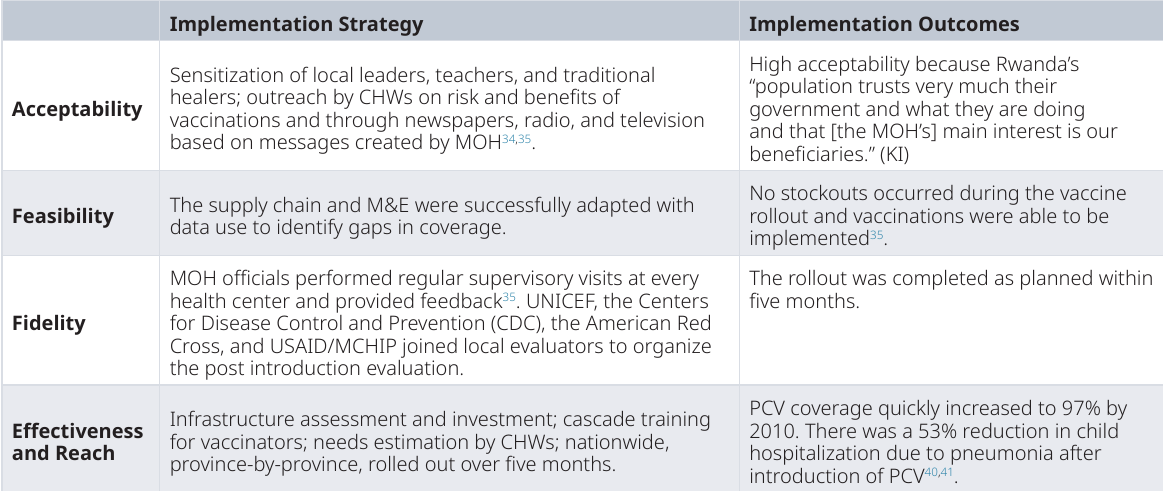
Table 4. Pneumococcal Vaccine Implementation Strategies and Selected Implementation